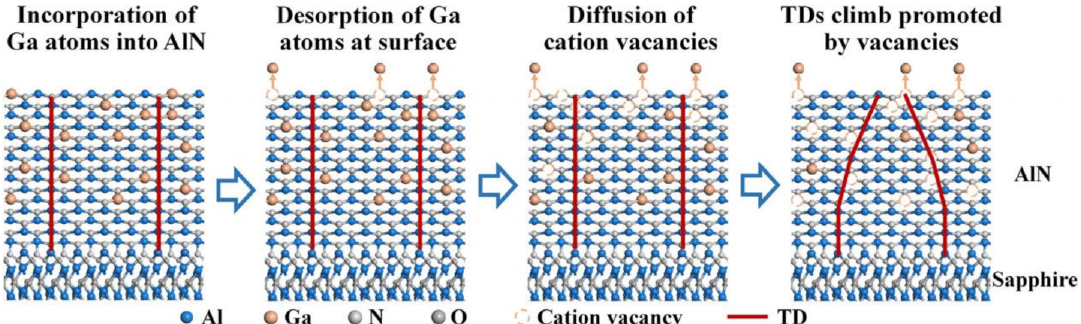
Figure 16. Schematic desorption mechanism of Ga atoms and dislocation evolution mechanism under the assistance of V Ga . Reprinted from [79], with the permission of AIP